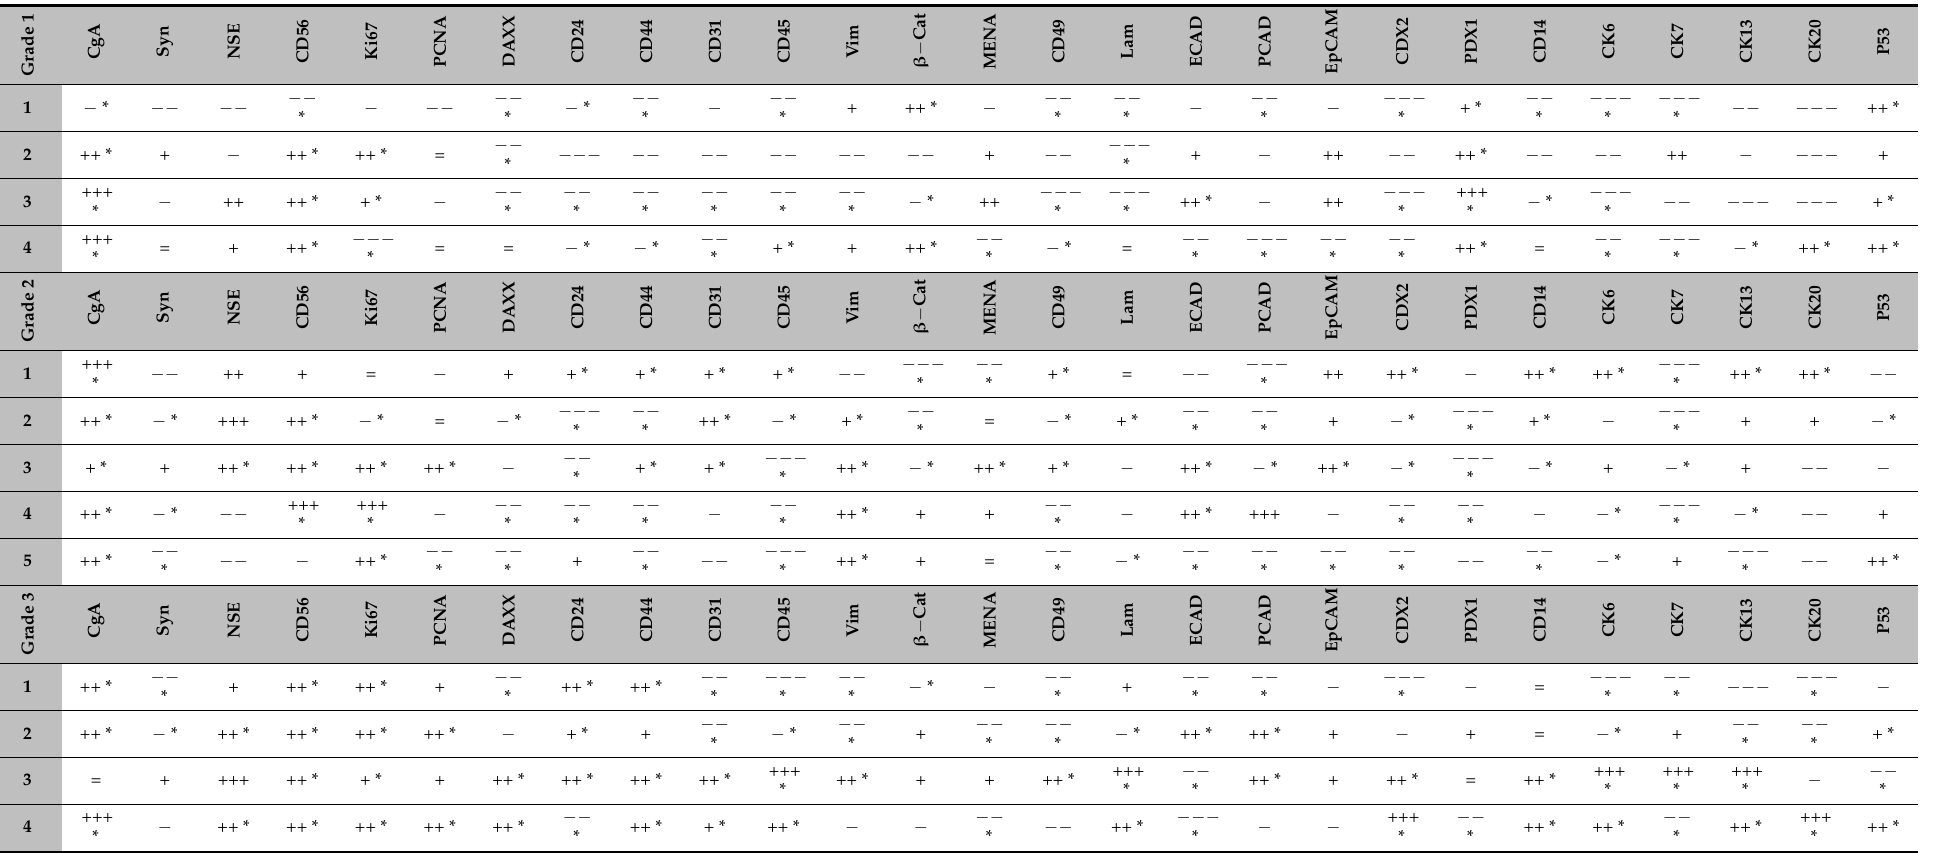
Table 1. mRNA levels of 27 markers in tumour tissue relative to matched non-tumour using β -actin as an endogenous